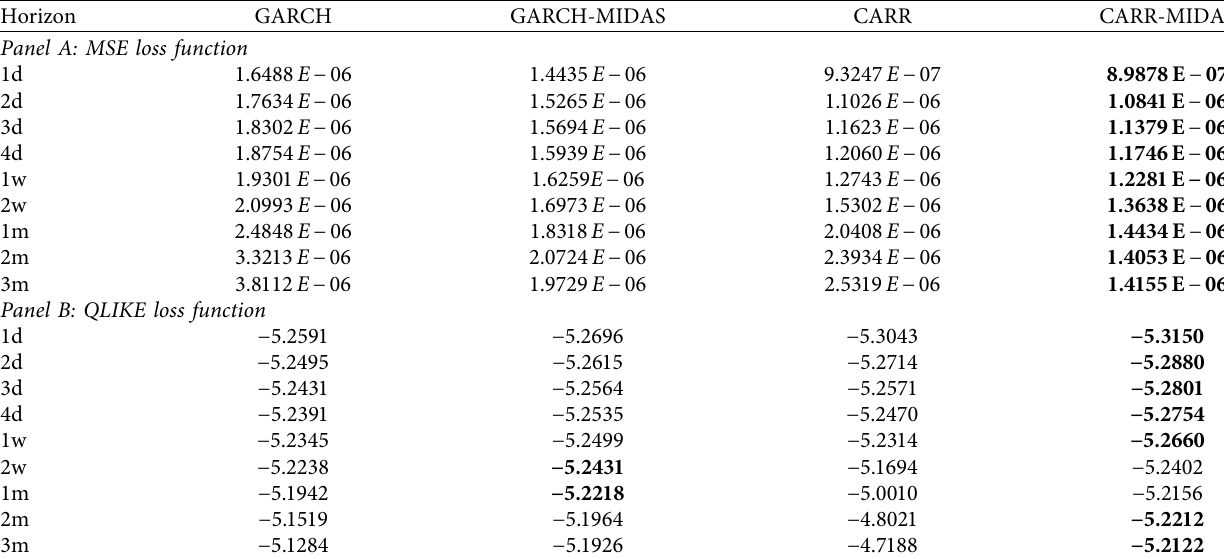
Table 6: Out-of-sample forecast evaluation results for forecast window of